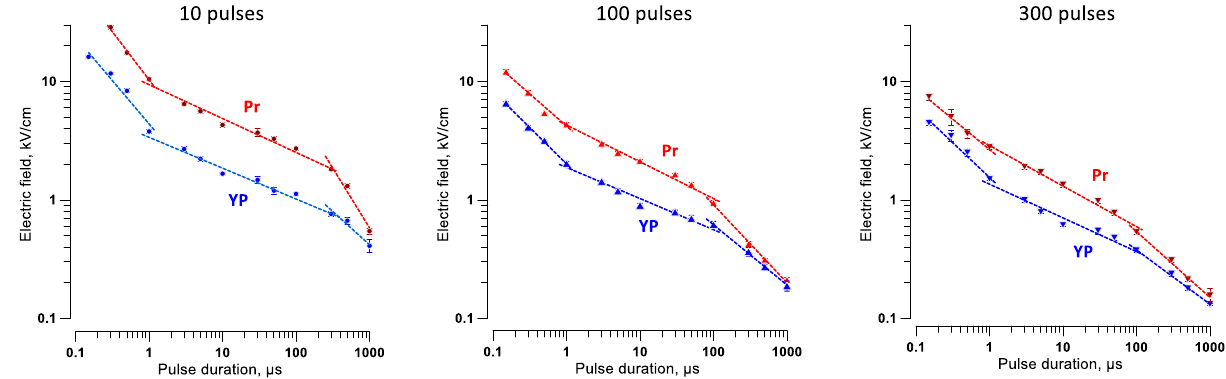
Figure 6. Electric field thresholds for electroporation (YP) and cell killing (Pr) by unipolar pulses of different duration. Trains of 10, 100, or 300 pulses (left to right panels) were applied at 10 Hz. Electroporation thresholds were measured from the borders of YO-PRO-1 (YP) dye uptake; the dye was added before the pulse treatment and removed 30 min after it. Electric field thresholds for cell death were measured from the borders of propidium (Pr) staining when the dye was added 4 h after the pulse treatment. See text for more details. Dashed lines are the best fits using power function, separately for pulse duration less than 1 µs; from 1 µs to 100 or 300 µs; and for still longer pulses. Error bars may be not visible when they are smaller than the central